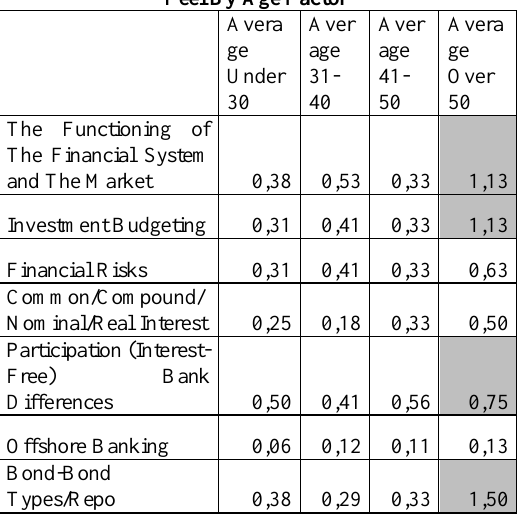
Table 7. Average Knowledge Level That Teachers